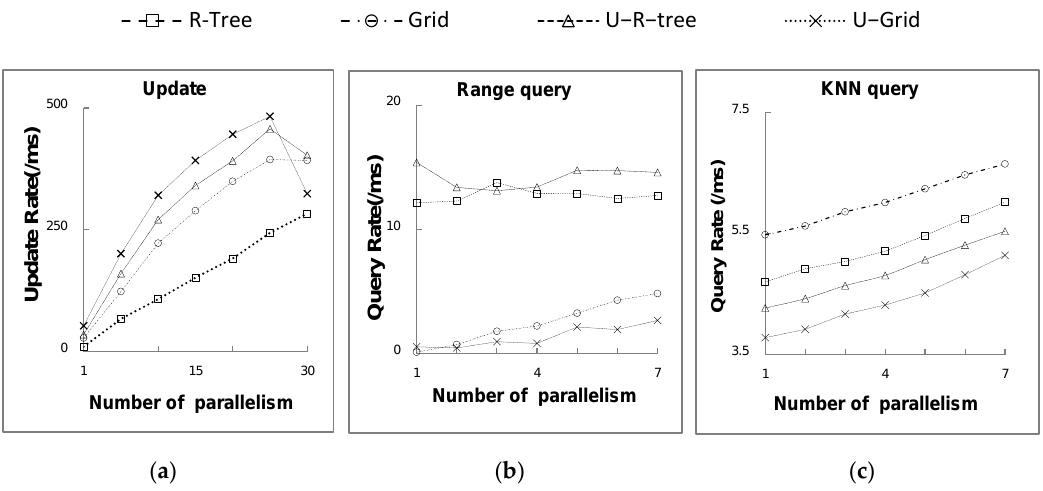
Figure 8. Single-dataset performance with different degrees of parallelism. ( a ) Update rate of spatial index; ( b ) query rate of range query; ( c ) query rate of KNN query.